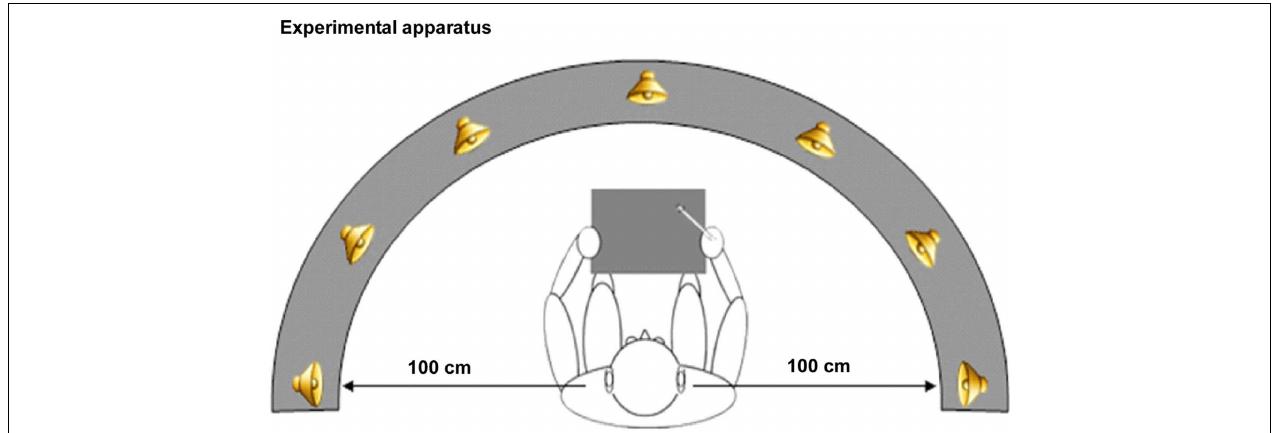
FIGURE 3 | Graphic representation of sound source locations. Seven sound sources were arranged in the participant’s median plane along a frontal arc of ± 90˚ ( − 90˚, − 60˚, − 30˚, 0, + 30˚, + 60˚, + 90˚) and centered on the participant’s head (1.0m distance).